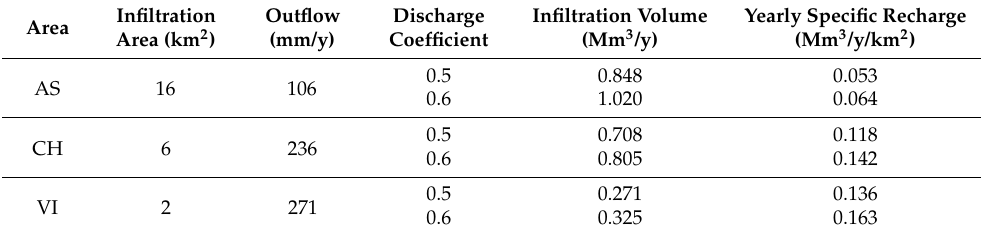
Table 6. Yearly specific recharge from historical data.